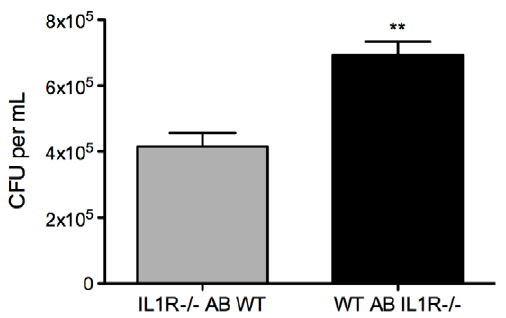
Figure 4. Antimycobacterial activity in macrophage co-cultures requires IL-1R expression on the naı¨ve cell population. Co- cultures were established with M.tb -infected IL-1R 2 / 2 macrophages and uninfected wildtype macrophages ( IL-1R 2 / 2 AB WT ) or vice versa ( WT AB IL-1R 2 / 2 ). CFU was measured at 0 and 48 h post-addition of naı¨ve macrophages. Results are expressed as the difference in mean CFU/ml